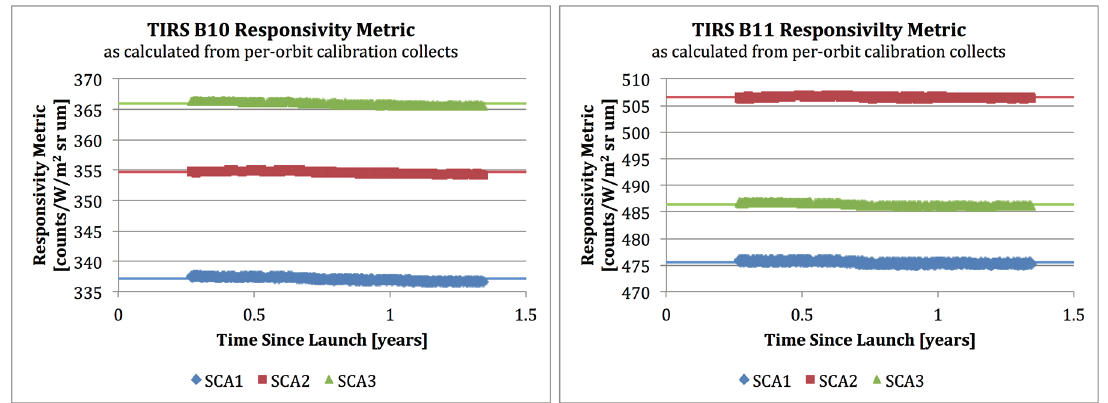
Figure 4. The SCA-average per-calibration sequence responsivity metric for both TIRS bands along with the per-SCA lifetime average. Based on this and other metrics, the TIRS instrument is internally